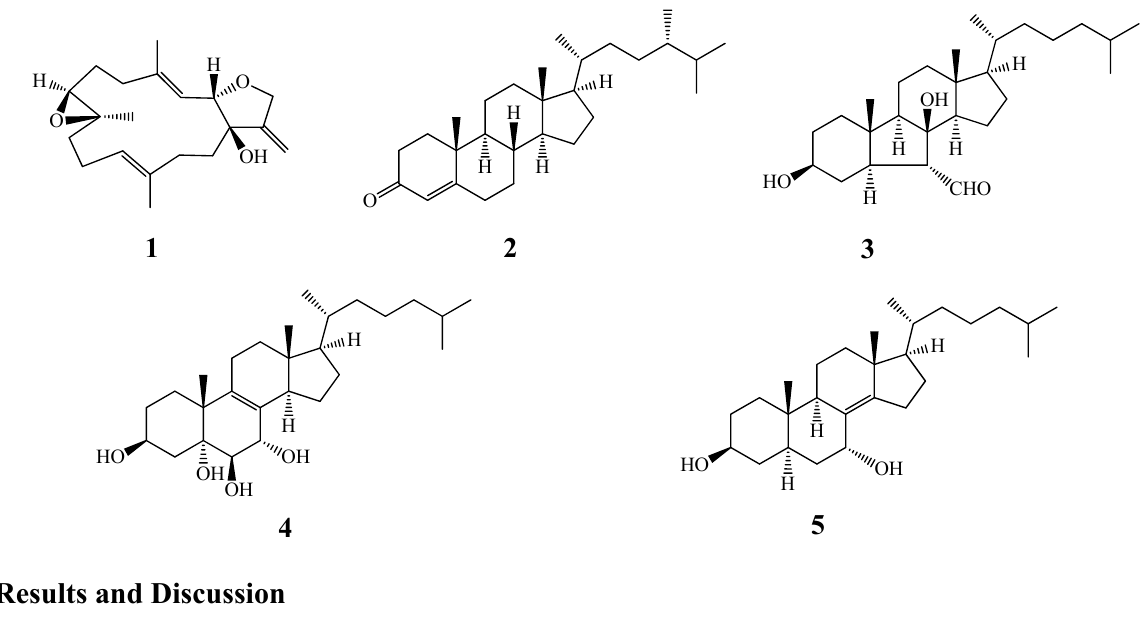
Figure 1. The chemical structures of compounds 1 – 5